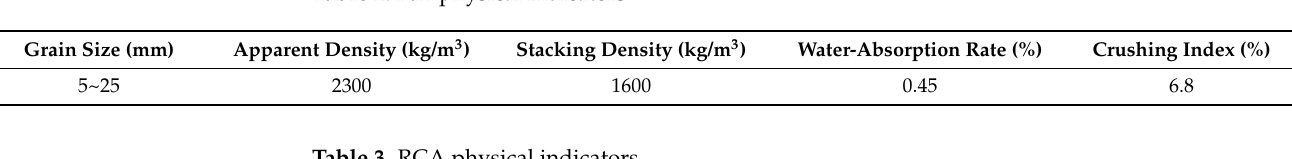
Table 2. NA physical indicators.